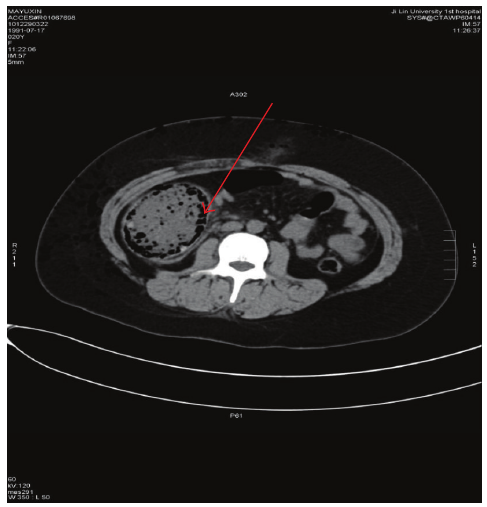
Figure 3: CT scan of abdomen shows distended ascending colon, contained fecal matter, and air entrapment (arrow) with postappen- dectomy